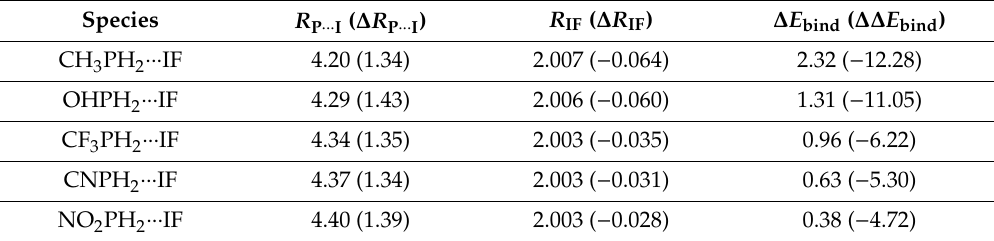
Table 6. Relaxed geometrical parameters ( R P ··· I , R IF ; Å), binding energy ( ∆ E bind ; kcal / mol), and dihalogen stretching frequency ( ν IF ; cm − 1 ) (with associated shifts from true equilibrium structure in parentheses) for $DEL-type variational reoptimizations, with the n P → σ * IF charge–transfer interaction